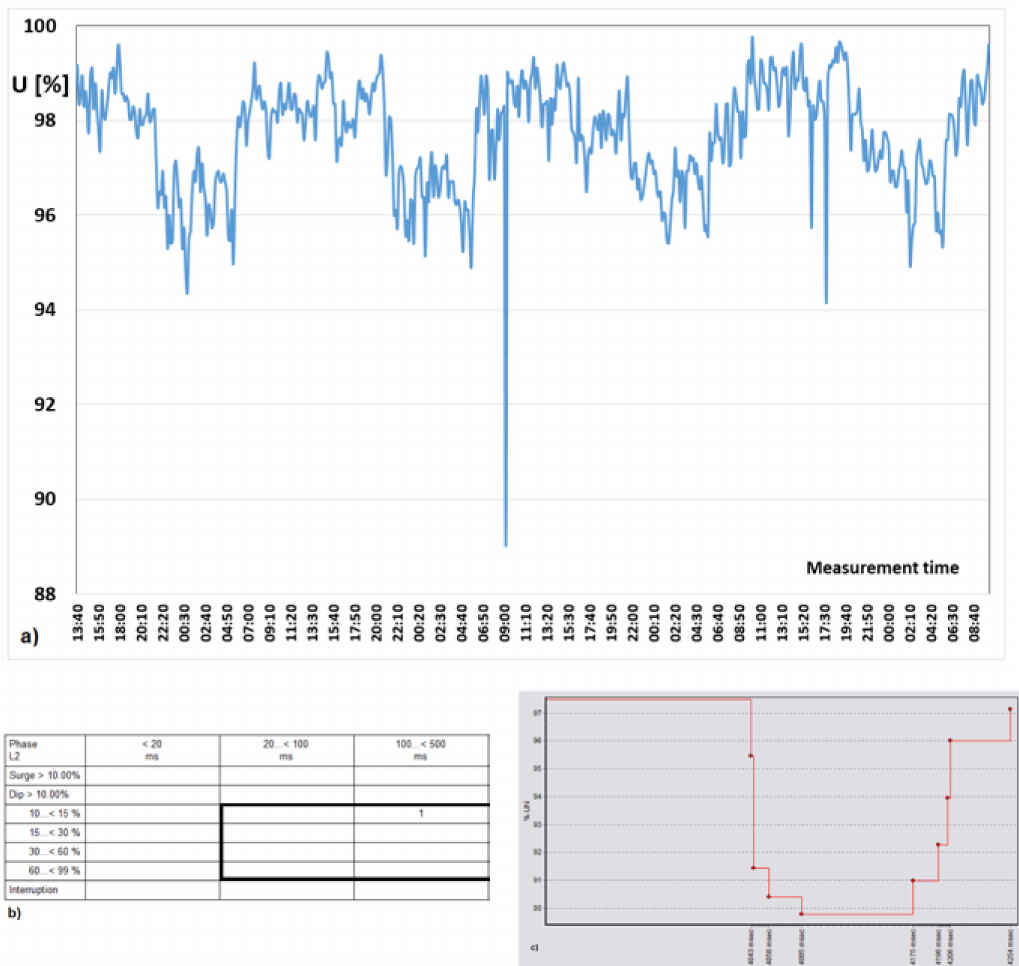
Figure 23. Changes in RMS voltage recorded during several days of measurements ( a ), voltage dip in UNIPEDE format ( b ), Change in RMS voltage during the dip ( c